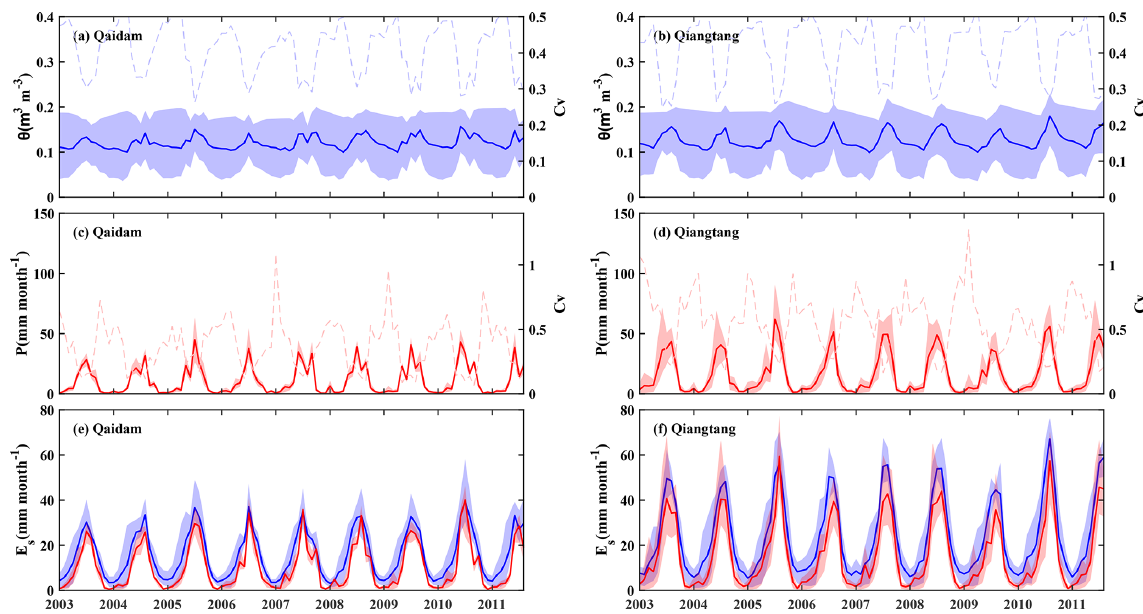
Figure 12. Monthly regional average (a, b) soil moisture datasets, (c, d) precipitation datasets, and (e, f) soil evaporation estimates, and their coefficients of variation over barrens of the Qaidam Basin and the Qiangtang Plateau. The shaded areas indicate the range determined by five datasets/estimates and solid lines represent the mean of them, depending on the left y axis. The light dashed lines represent coefficients of variation of five datasets/estimates, depending on the right y axis. Blue represents results of soil moisture datasets or E s estimates derived from soil moisture, and red represents results of precipitation datasets or E s estimates derived from